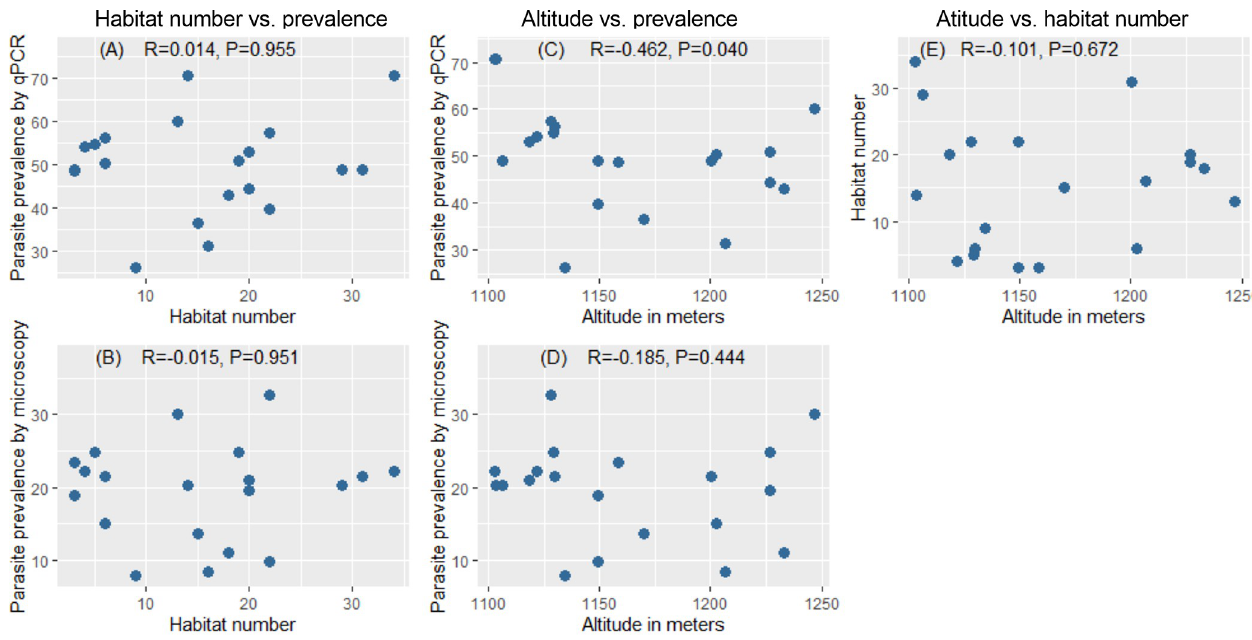
Fig 3. Relationships among prevalence, habitat number, and altitude across clusters. The habitats comprise forest, wetland and sugarcane combined. Each dot represents a cluster. Two clusters had identical prevalence of 70.6% by qPCR thus dots overlap. R values are calculated by spearman correlation.